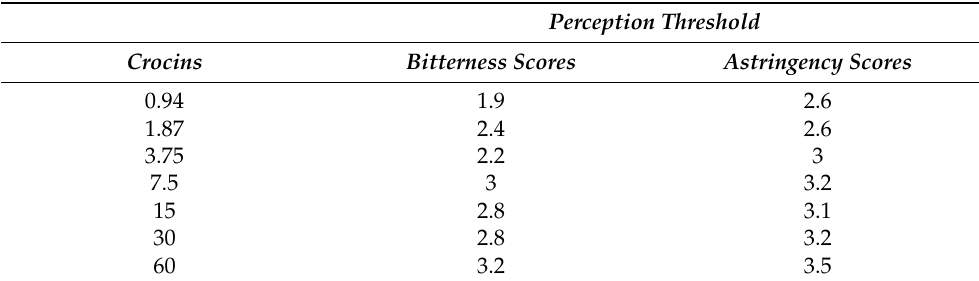
Figure 1. Attributes intensity as defined by panel thresholds. Attributes found to be significantly different (Tukey’s HSD test) are indicated by *, **, ***, referred to significant F-values: * 0.05, ** 0.01 or *** 0.001 levels. Table 3. Crocins are calculated as ppm (parts per million). Threshold scores refer to the attribute intensity of bitterness and astringency at different crocin